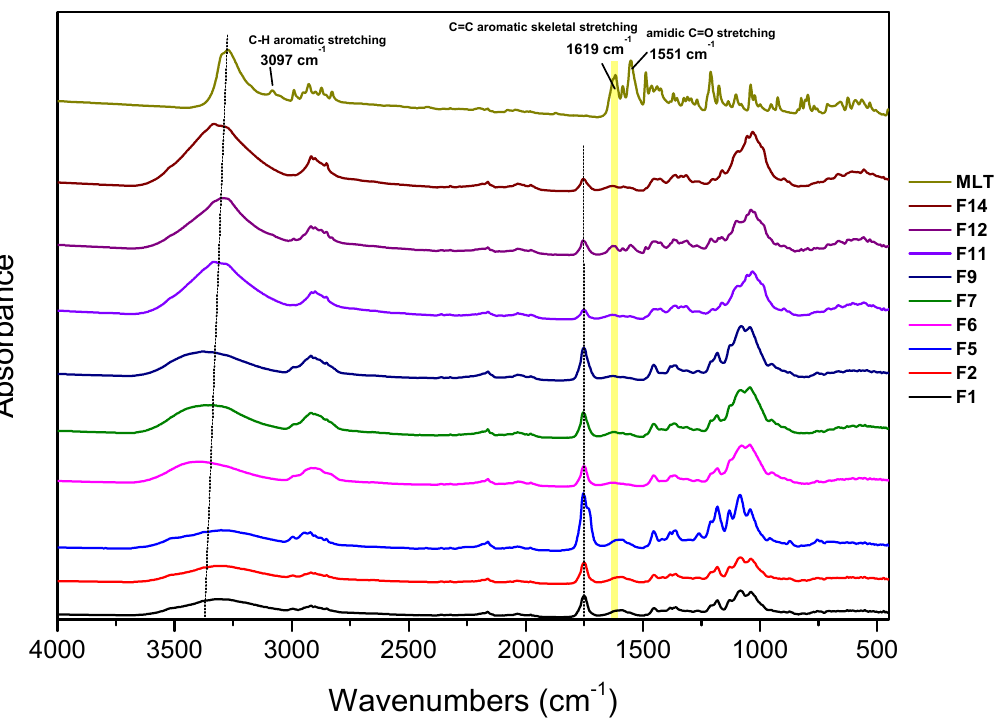
Figure 2. ATR-FTIR spectra of pure melatonin and selected prepared formulations (F1, F2, F5, F6, F7, F9, F11, F12, and F14).